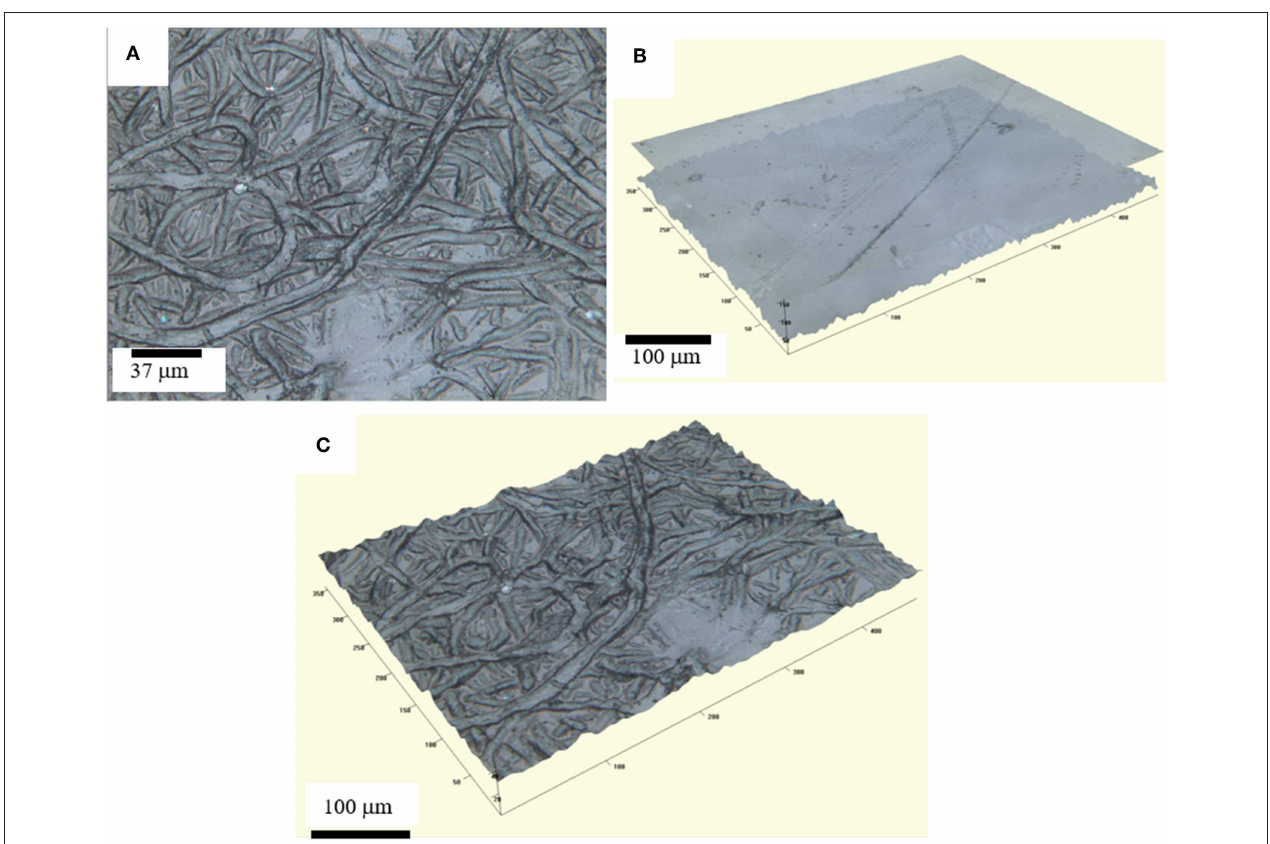
FIGURE 9 | 3D micrographs of the Su/ePLA/Su reinforced sandwich obtained with 3D Optical Profilometry: (A) plain view; (B) 3D micrograph with observation of the Surlyn ® superior layer and the inner PLA layer: (C) 3D micrograph of the PLA inner